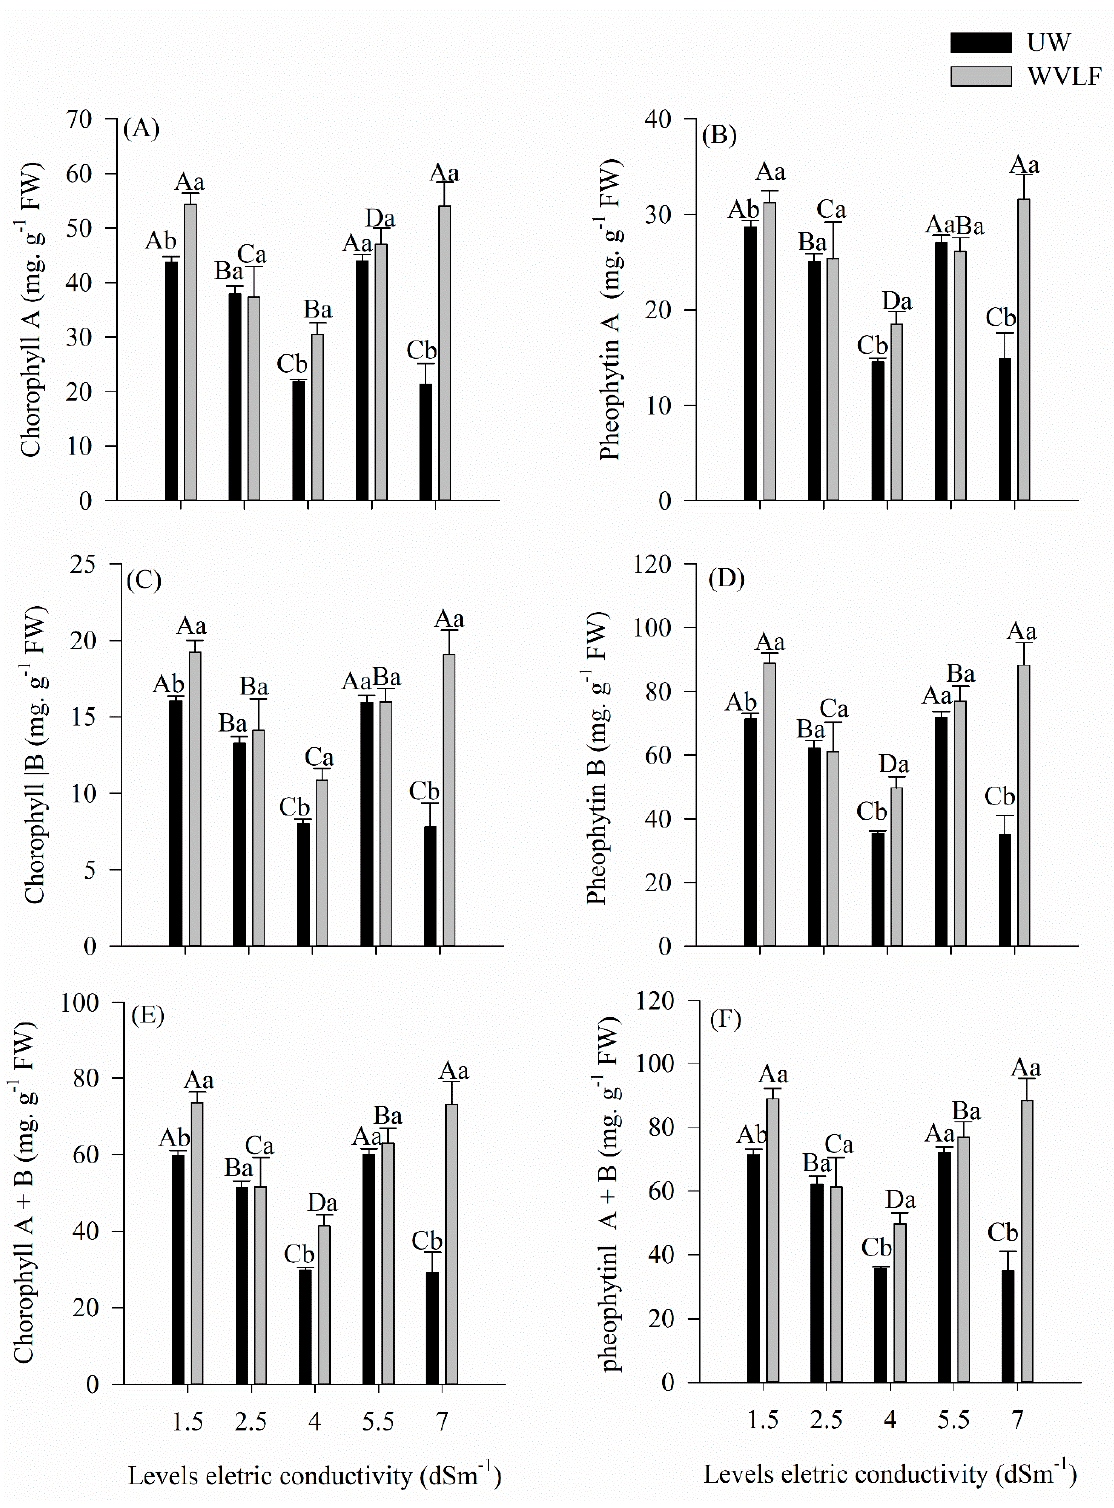
Figure 2. Chlorophyll A contents ( A ); Pheophytin A ( B ); Chlorophyll B ( C ); Pheophytin B ( D ); Chlorophyll A + B ( E ); and Pheophytin A + B ( F ) for the different levels of fertigation, and the handling of irrigation with electromagnetically treated (WVLF) and untreated water (UW). Means followed by the same letter (lowercase compares the type of water and uppercase compares the salinity doses) do not differ statistically ( p < 0.05) according to the Tukey test. Error bars indicate the standard deviation of the mean of four replicates ( n = 4).